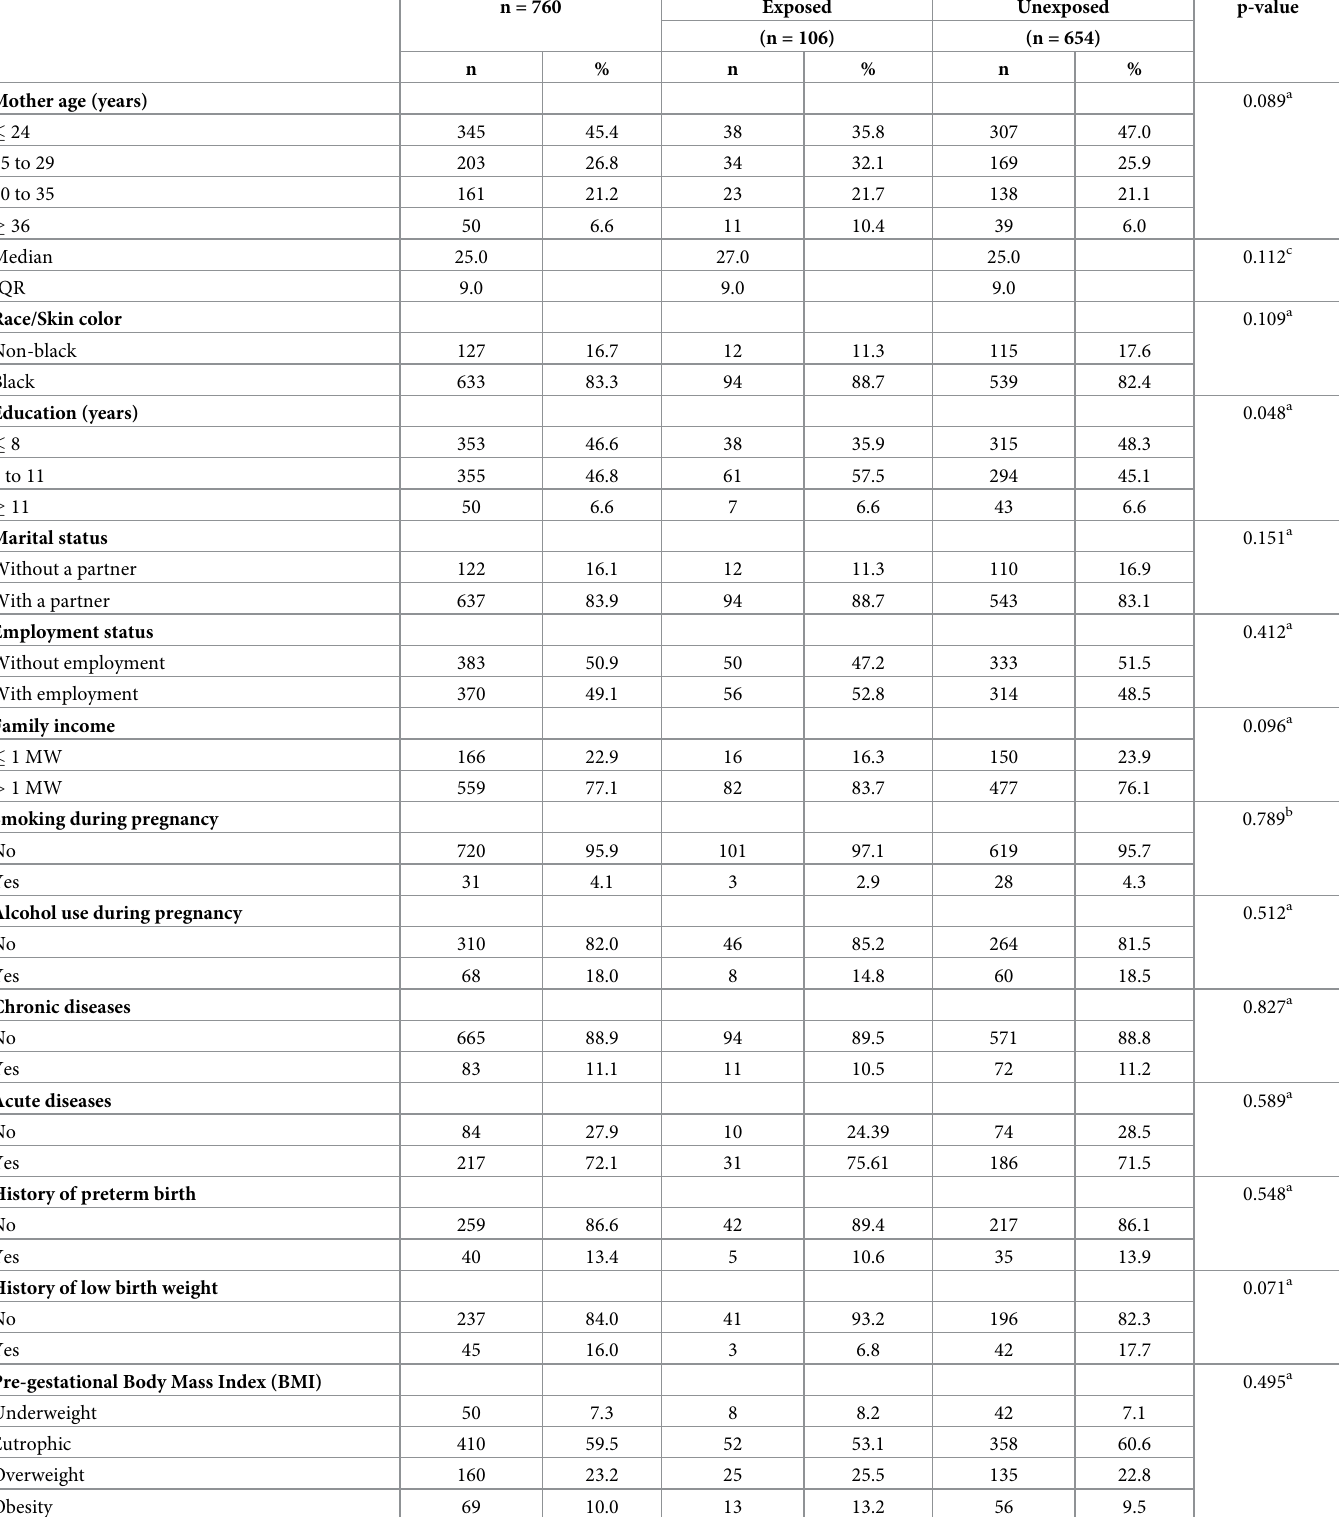
Table 1. Characteristics of the study population. NISAMI Cohort Study, Brazil 2012–2014 (N = 760) � . n = 760 Exposed